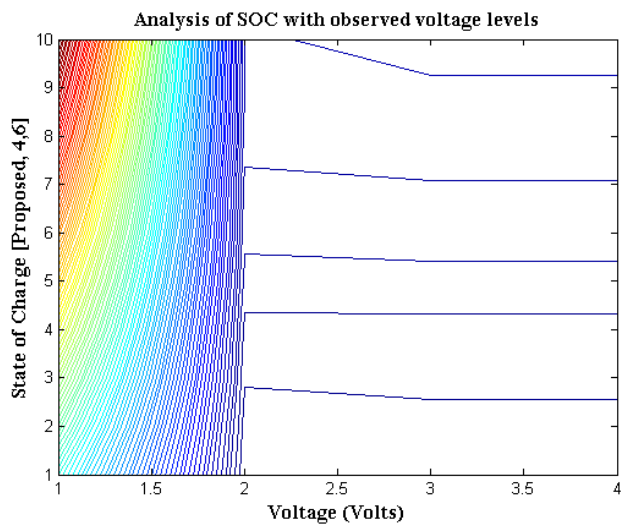
Figure 4. State of charge for consistent voltage levels.